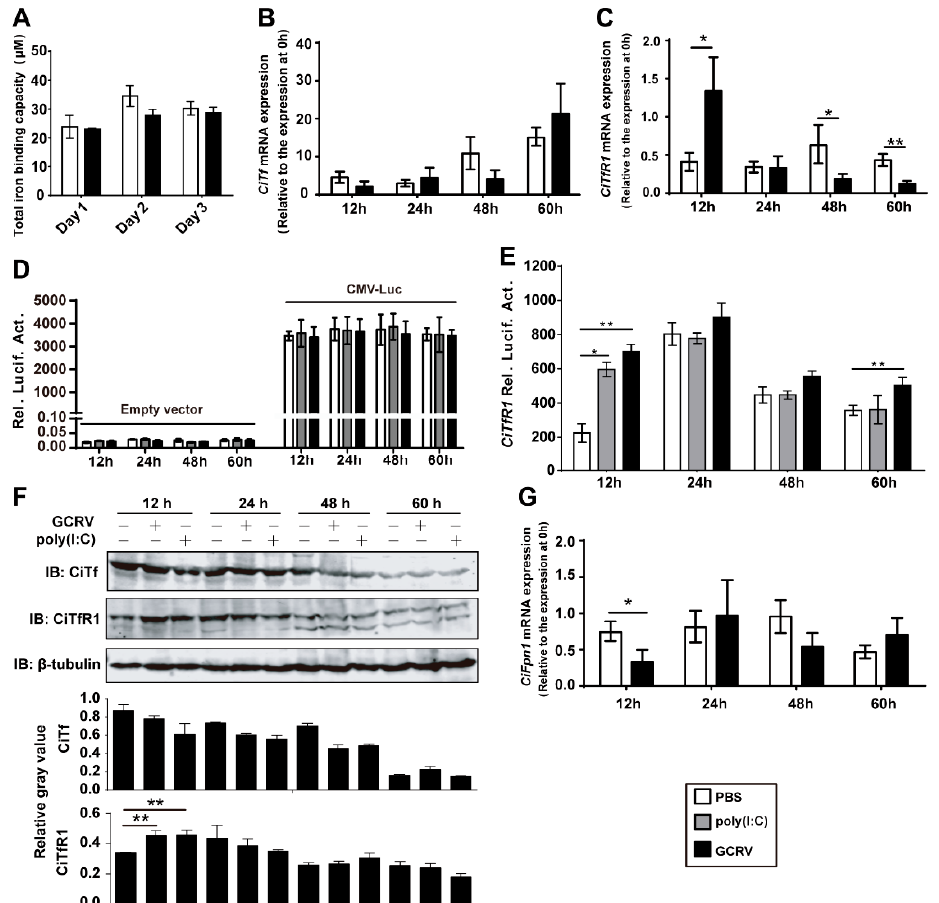
Figure 3. The expression of CiTfR1 rather than CiTf is enhanced at the early stage of GCRV infection. ( A ) The total iron-binding capacity (TIBC) in grass carp serum was detected by using an automatic biochemistry analyzer. ( B , C , G ) The relative mRNA expression levels of CiTf ( B ), CiTfR1 ( C ), and CiFpn1 ( G ) in CIK cells after GCRV infection. CIK cells were seeded into 12-well plates (1× 10 6 /well) 24 h before GCRV infection. The experimental group was infected with GCRV, while the control group was treated with PBS. Then, cells were harvested at the indicated time points. Data are presented in relative expression units where EF1 α was used to normalize samples. The expression level of each gene in CIK cells at 0 h was deemed as standard level (relative level is 1). ( D , E ) The effects of GCRV infection or poly(I:C) stimulation on the promoter activity of the CiTfR1 gene. In total, CIK cells were seeded into 24-well for 24 h cultivation (5 × 10 5 /well), and then cells were cotransfected with 38 ng pRL-TK and 760 ng pGL3-basic, pCMVpro-Luc ( D ), or pTfR1pro-Luc ( E ). Twenty-four hours later, the cells were infected with GCRV or treated with PBS or poly(I:C), and then cells were harvested at the indicated time points for the detection of luciferase activities. ( F ) The effects of GCRV infection or poly(I:C) stimulation on the protein levels of CiTf and CiTfR1 genes. CIK cells were seeded in six-well plates for 24 h cultivation (3 × 10 6 /well), and then the cells were infected with GCRV or treated with PBS or poly(I:C). At the indicated time points, cells were harvested, and the cell lysates were used for WB analysis. Data represent mean ± SD of three independent experiments. * p < 0.05, ** p < 0.01.